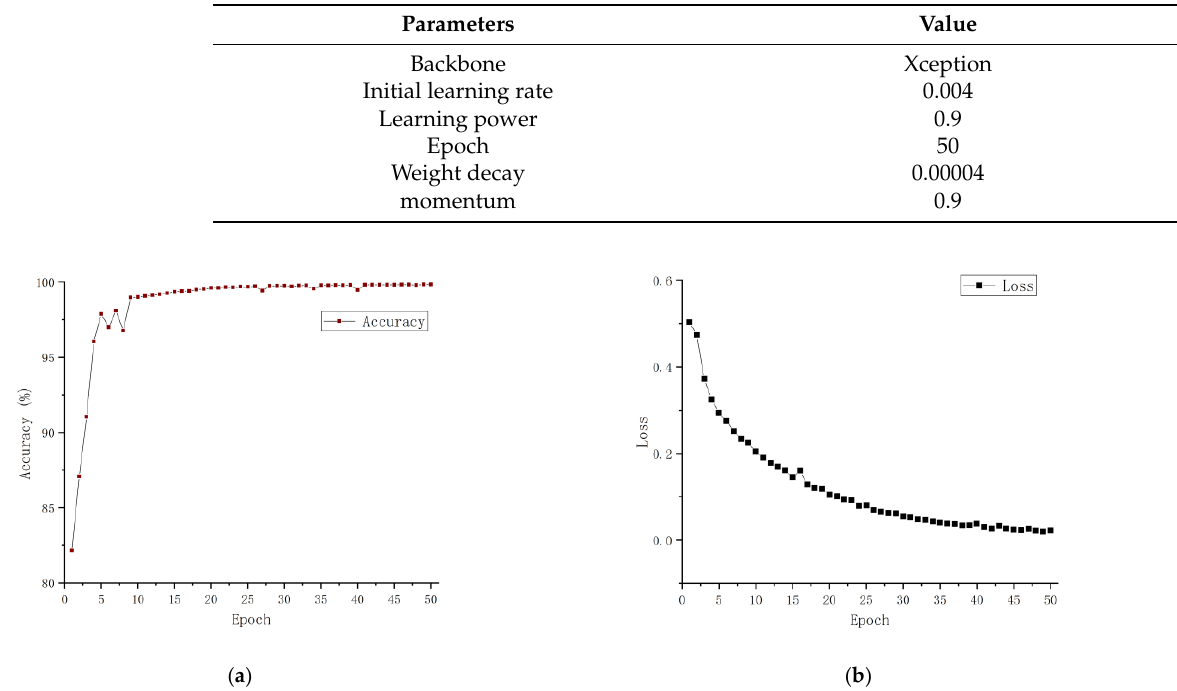
Table 1. Training parameters of DeepLabV3+.